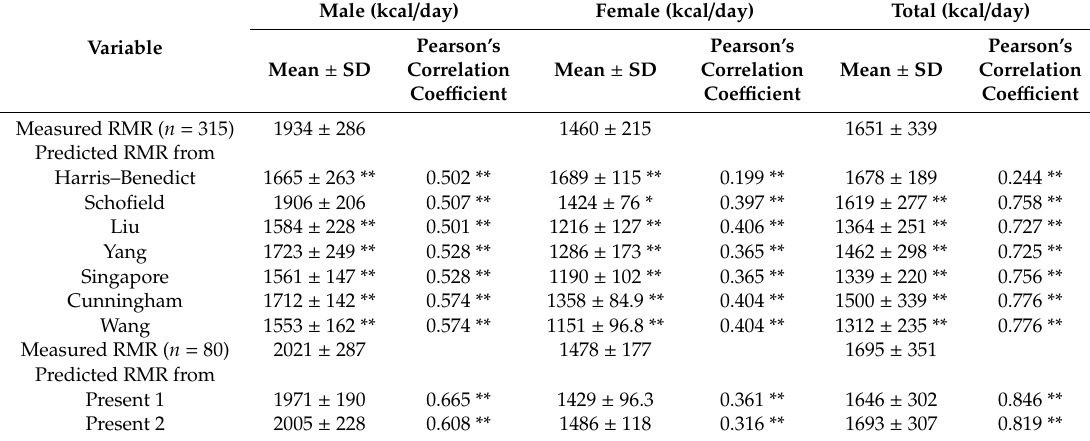
Table 3. Comparison of RMR values from predictive equations and indirect